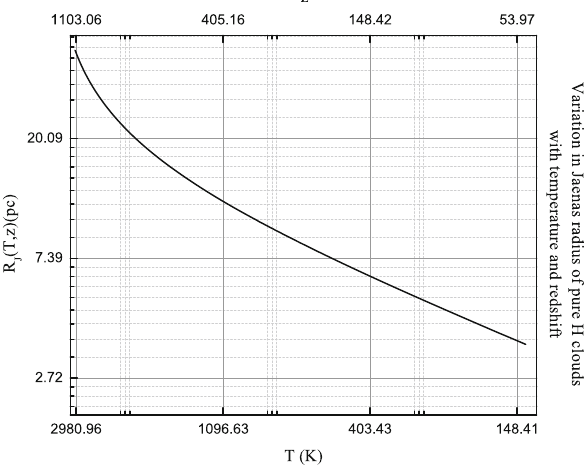
Fig. 1 Variation in the central density ρ c of the virial clouds with respect to both the red shift (indicated by the upper horizontal axis) and the CMB temperature (bottom axis) for pure H clouds